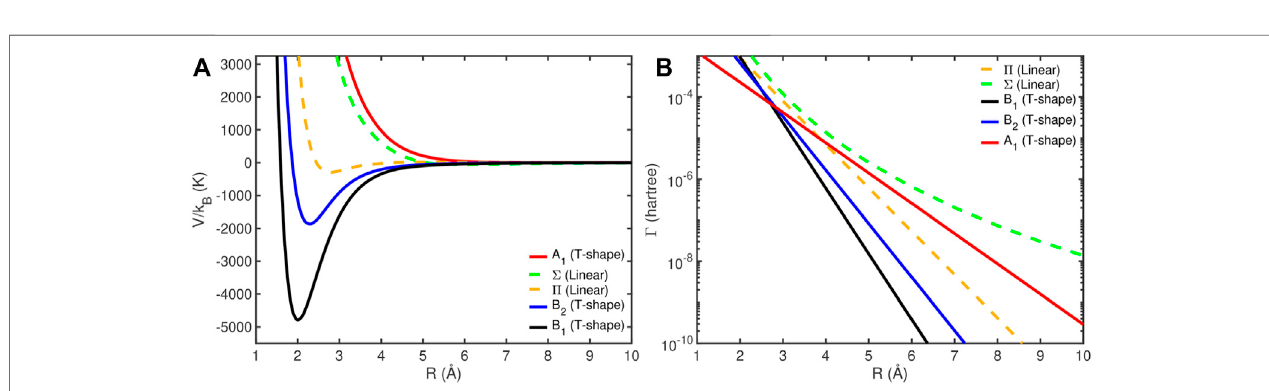
Frontiers in Physics |